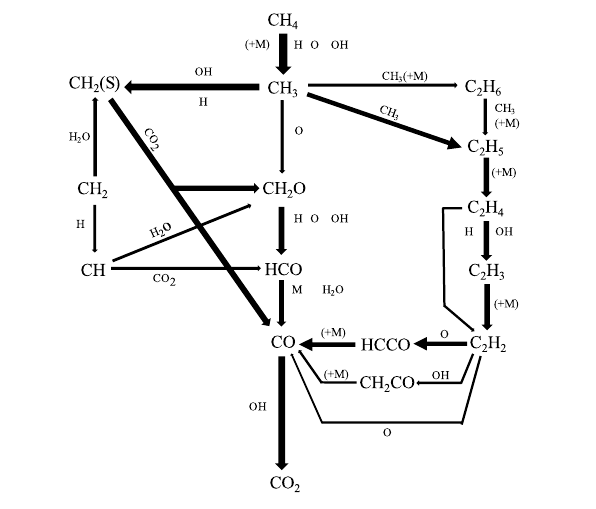
FIGURE 10 | Integral reaction fl ow in a laminar non-premixed CH 4 jet fl ame in an O fl ow at V 2 /CO 2 co F = 10 m/s (thick lines show the major